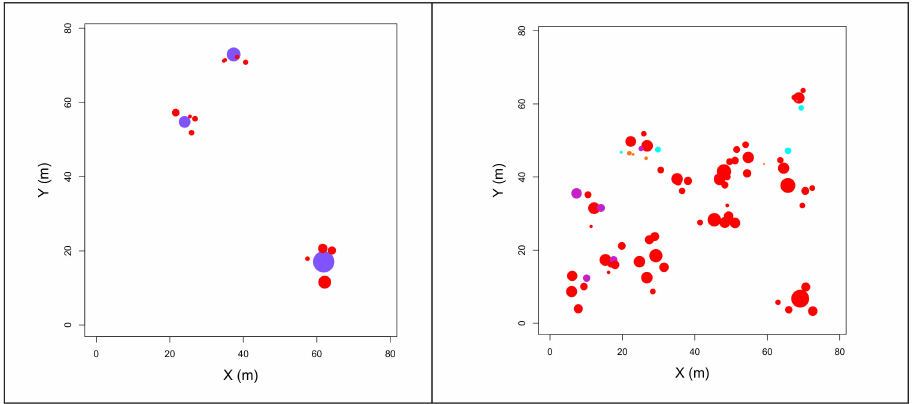
Figure 7. Two edge-corrected sets of reference and their four-tree neighborhoods in plot A (cropped to 80 × 80 m): all Quercus castaneifolia trees with dbh > 50 cm (left); all Taxus baccata trees with dbh > 50 cm